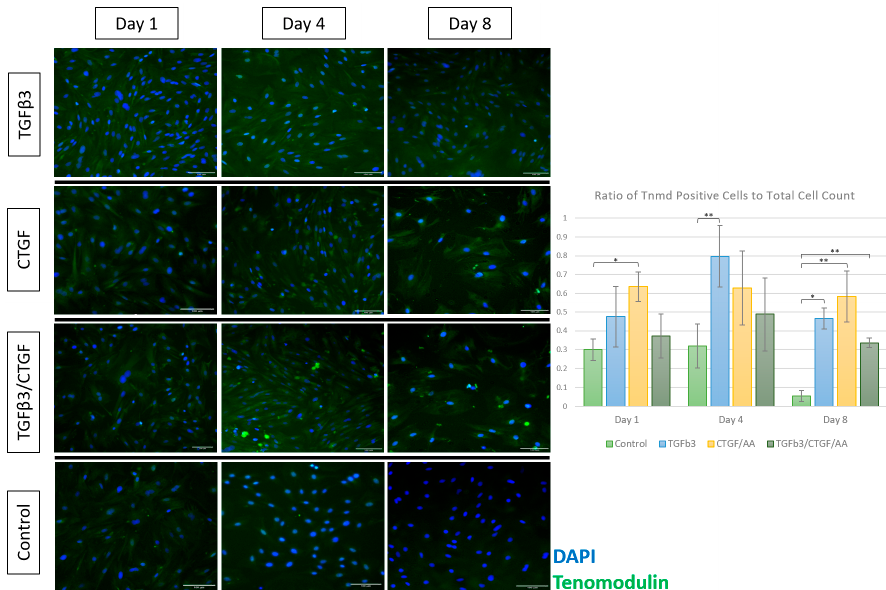
Figure 6. Expression of tenomodulin (green) in rAdMSCs exposed to TGF- β 3 (10 ng/mL), CTGF (100 ng/mL) with 50 μ g/mL ascorbic acid, or TGF- β 3 (10 ng/mL), CTGF (100 ng/mL), and 50 μ g/mL ascor- bic acid at Days 1, 4, and 8 of culture; cell nuclei counterstained with DAPI (blue). Immunofluores- cence staining of tenomodulin was significantly upregulated in the group treated with CTGF/ascor- bic acid (AA) on Day 1, in the group treated with TGF β 3 on Day 4, and in the groups treated with CTGF/AA, TGF β 3, and TGF β 3/CTGF/AA on Day 8. Scale bar = 100 μ m. “*” represents p < 0.05 and “**” represents p < 0.01 in pairwise comparison.